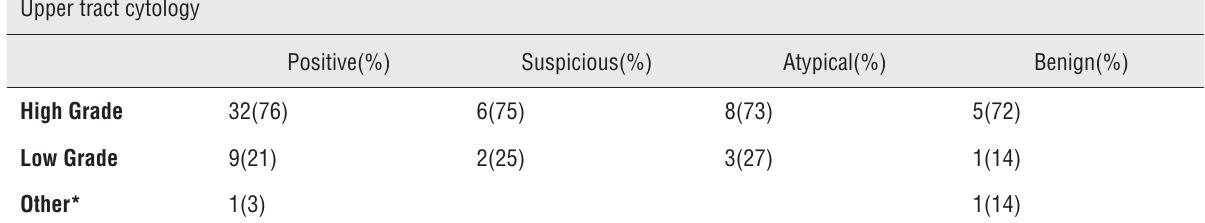
Table 3 - UTC and tumor